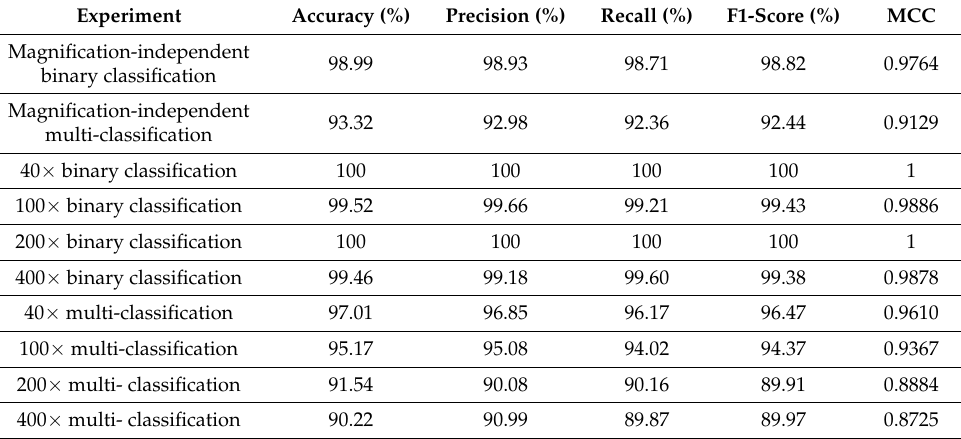
Table 14. Results of the best-performing model (Xception model at a learning rate of 0.0001) in all conducted experiments.